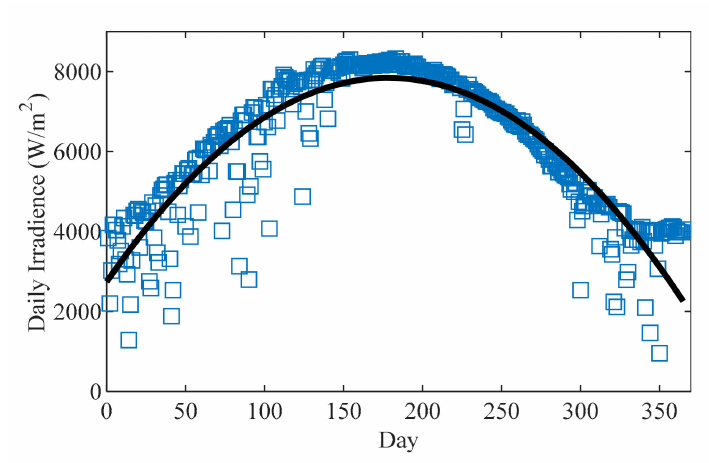
Figure 4. Irregular fluctuations in total solar irradiation for year 2019.